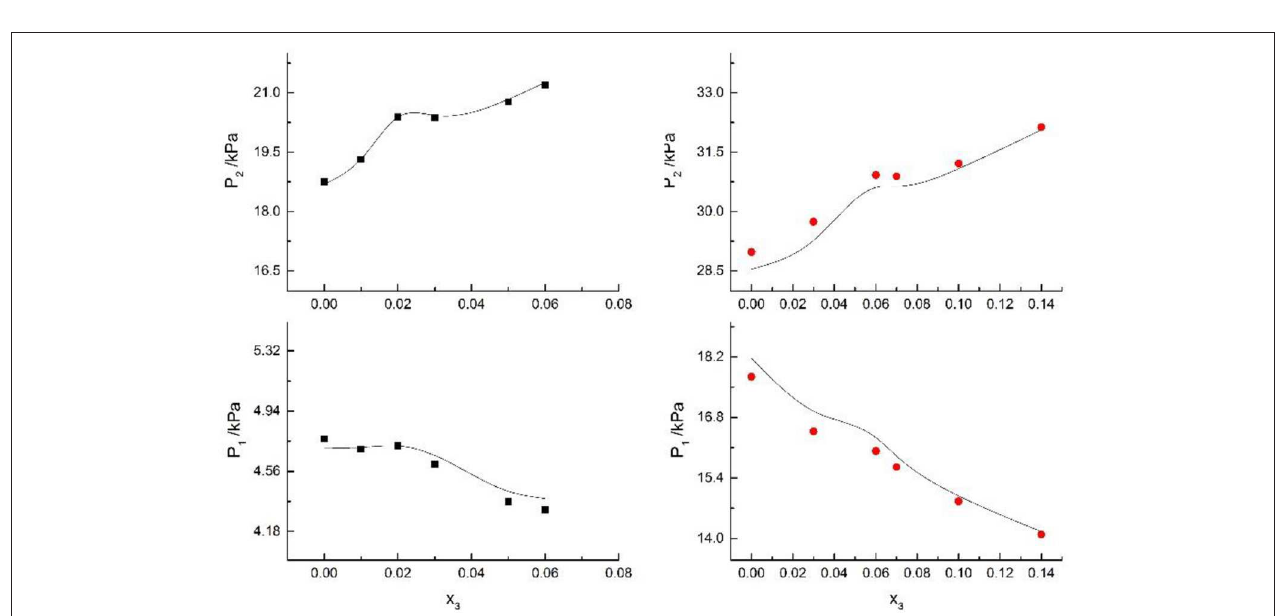
FIGURE 6 | Correlation of VLE data of H2O(1) + CH3OH(2) + NaBr(3) system. Filled symbols ( (cid:4) x2 = 0.45 and T = 315K; • x2 = 0.22 and T = 335K) indicate Literature data (Xu et al., 2018); curves indicate correlation of the model.